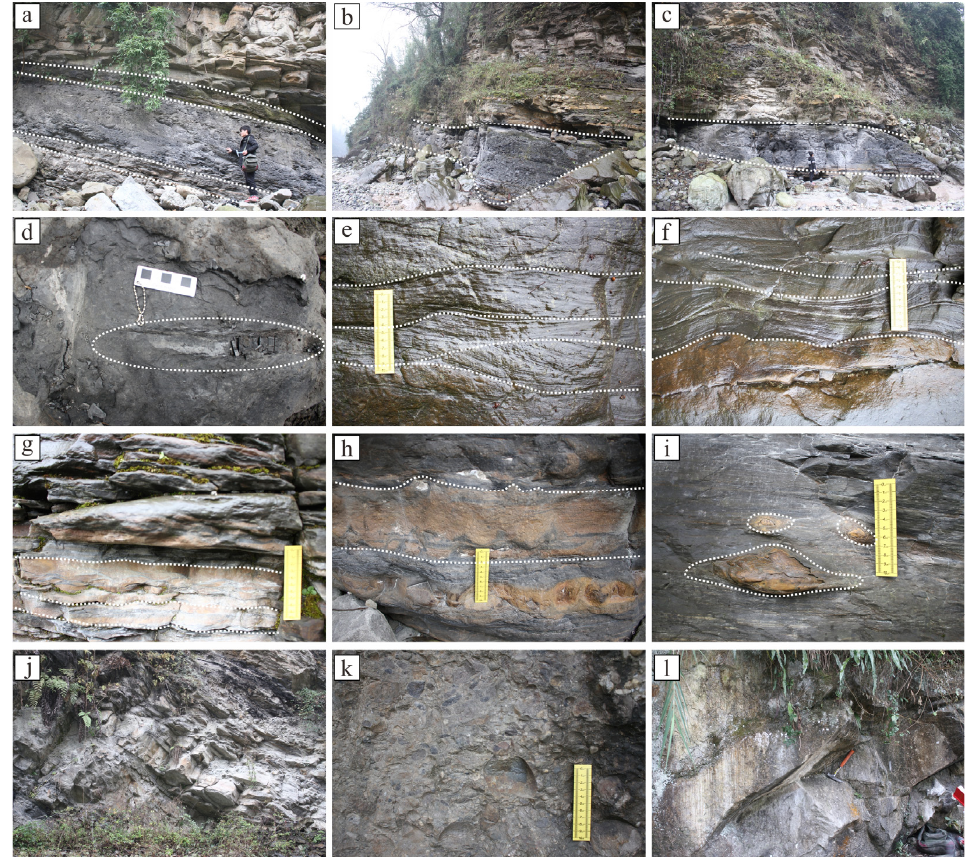
Figure 2. Field outcrop chart of fine-grained rocks of the Xu-3 Member in the Western Sichuan Depression. ( a – c ) Exposure of fine-grained sedimentary rocks of the Xu-3 Member in the JH section; ( d ) Fossil plant stems in the Xu-3 Member; ( e , f ) Trough cross bedding of the Xu-3 Member in the TGM section; ( g ) Flaser bedding in the Xu-3 Member; ( h ) Flame structure bedding; ( i ) Lenticular siderite nodule; ( j ) Sandstone of the Xu-2 Member in the TGM section; ( k ) Conglomerates at the boundary between the Xu-3 Member and the Xu-4 Member in the TGM section; ( l ) Sandstone of the Xu-4 Member in the TGM section.